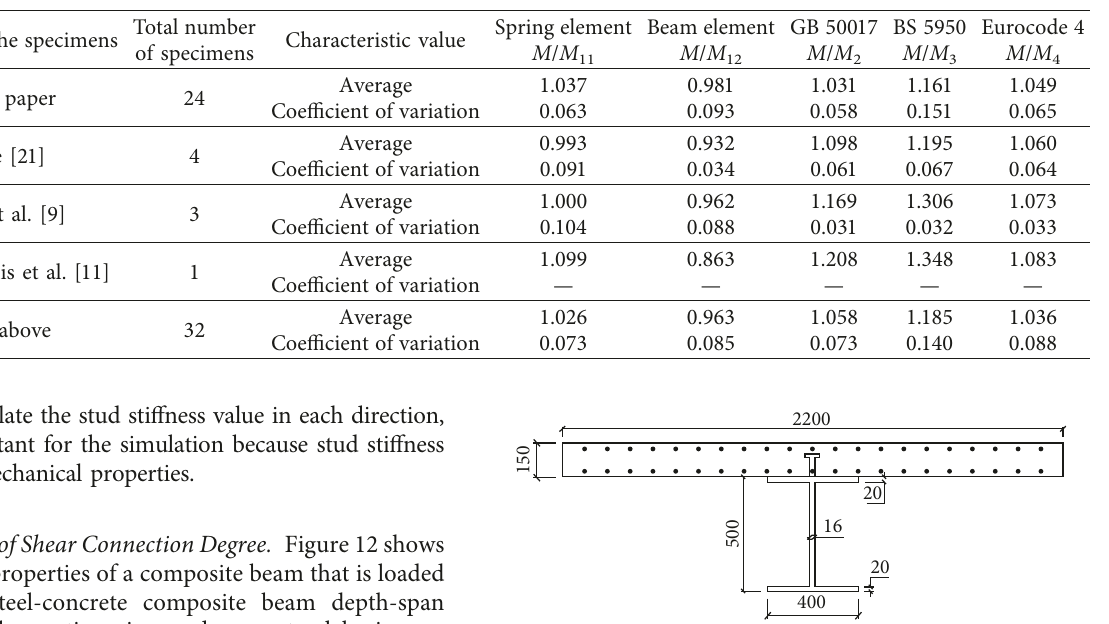
Table 3: Comparison among the three standards and simulated and test results.